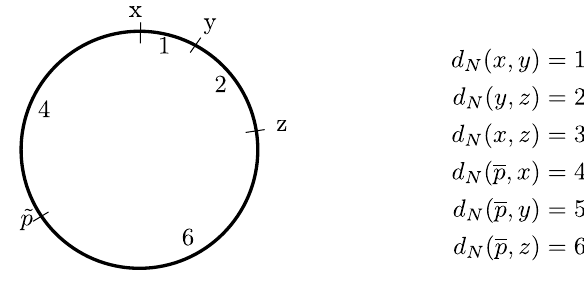
Figure 3: Points along a circle N of length 13 and